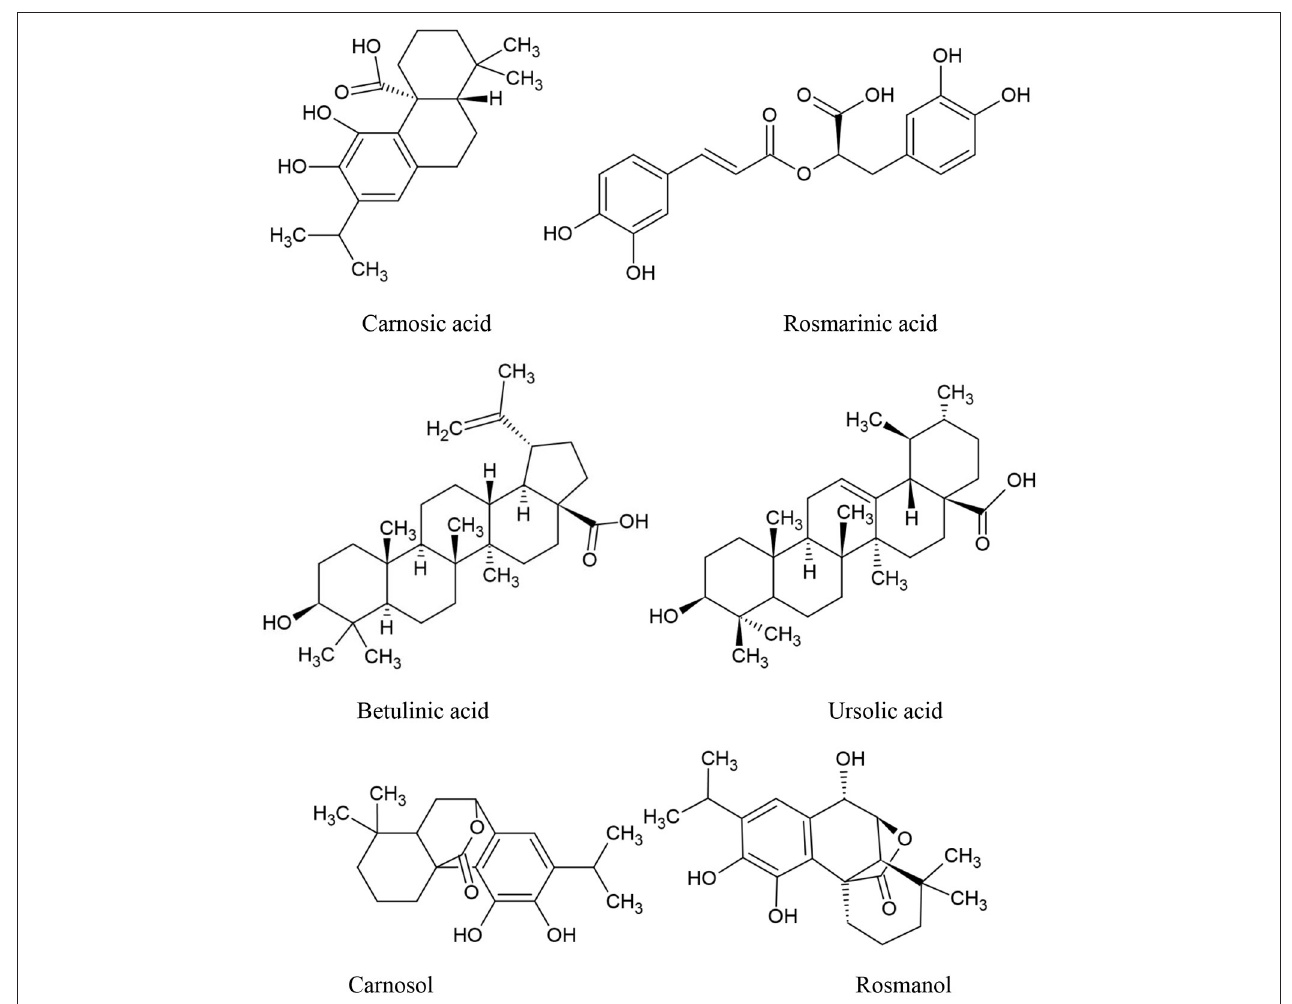
FIGURE 3 | The main components of Rosmarinus officinalis chemical